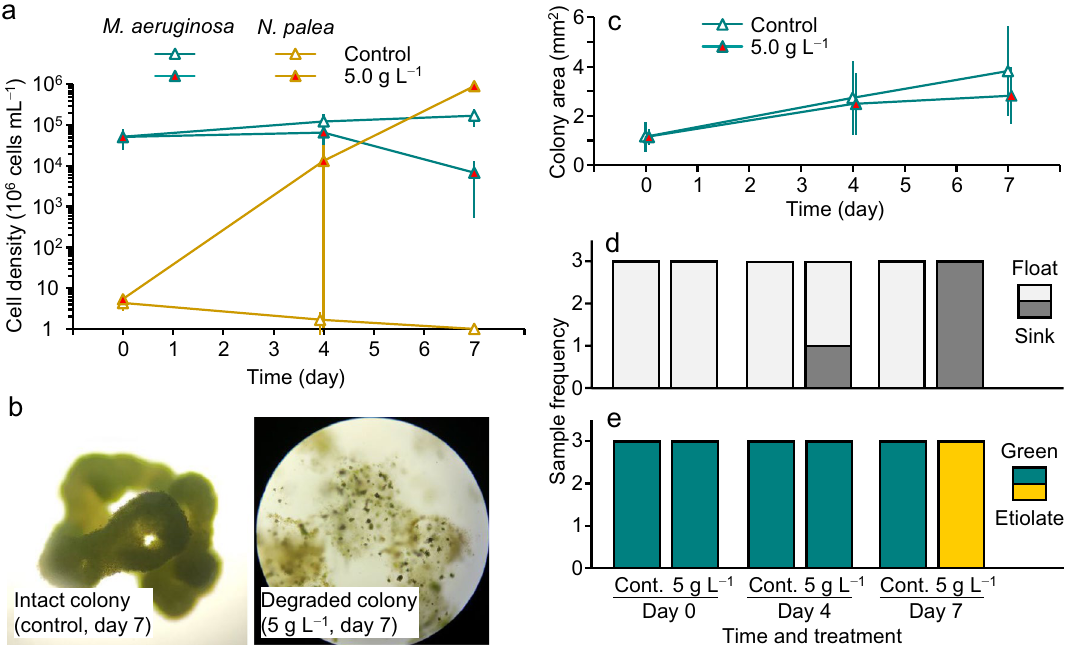
Figure 5. Growth patterns of Microcystis aeruginosa and Nitzschia palea ( a ) and changes in colony of M. aeruginosa ( b ), including size ( c ), float/sink status ( d ), and color state ( e ), in the control and 5 g L −1 treatment in co-culture with colony-forming M. aeruginosa . Error bars are SD ( n = 3).